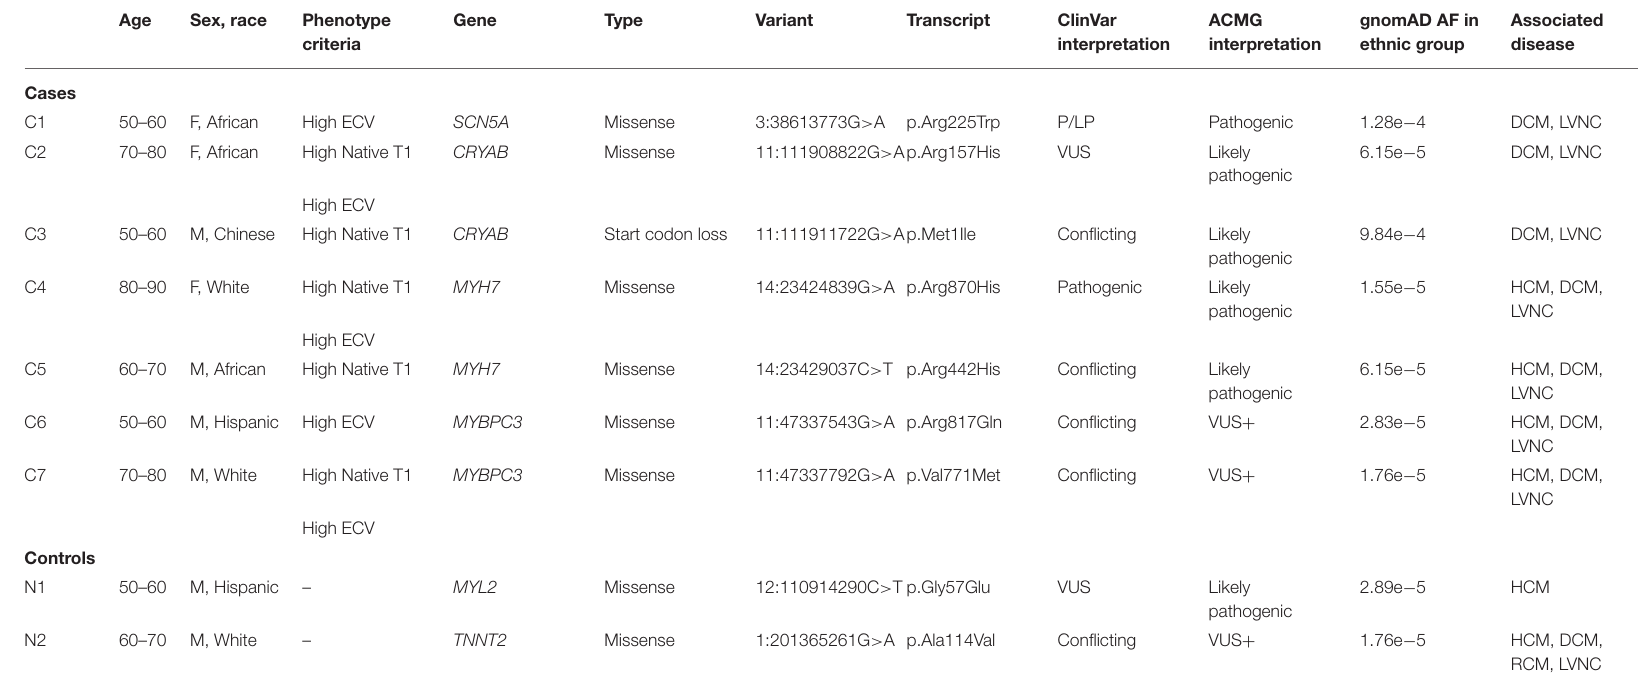
TABLE 2 | Cases/Controls with pathogenic/likely pathogenic variants and VUS + in cardiomyopathy genes with AD pattern of inheritance. Age Sex, race Phenotype Gene Type Variant criteria